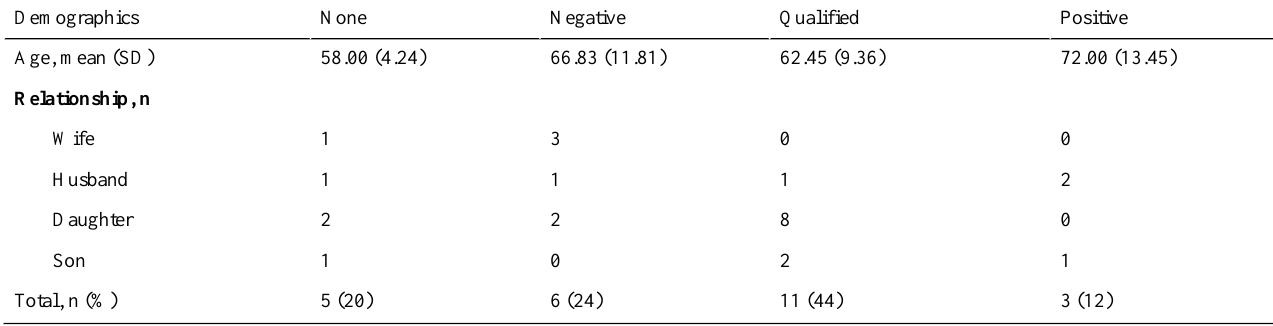
Table 3. Caregivers’profiles and opinions about the Web-based program